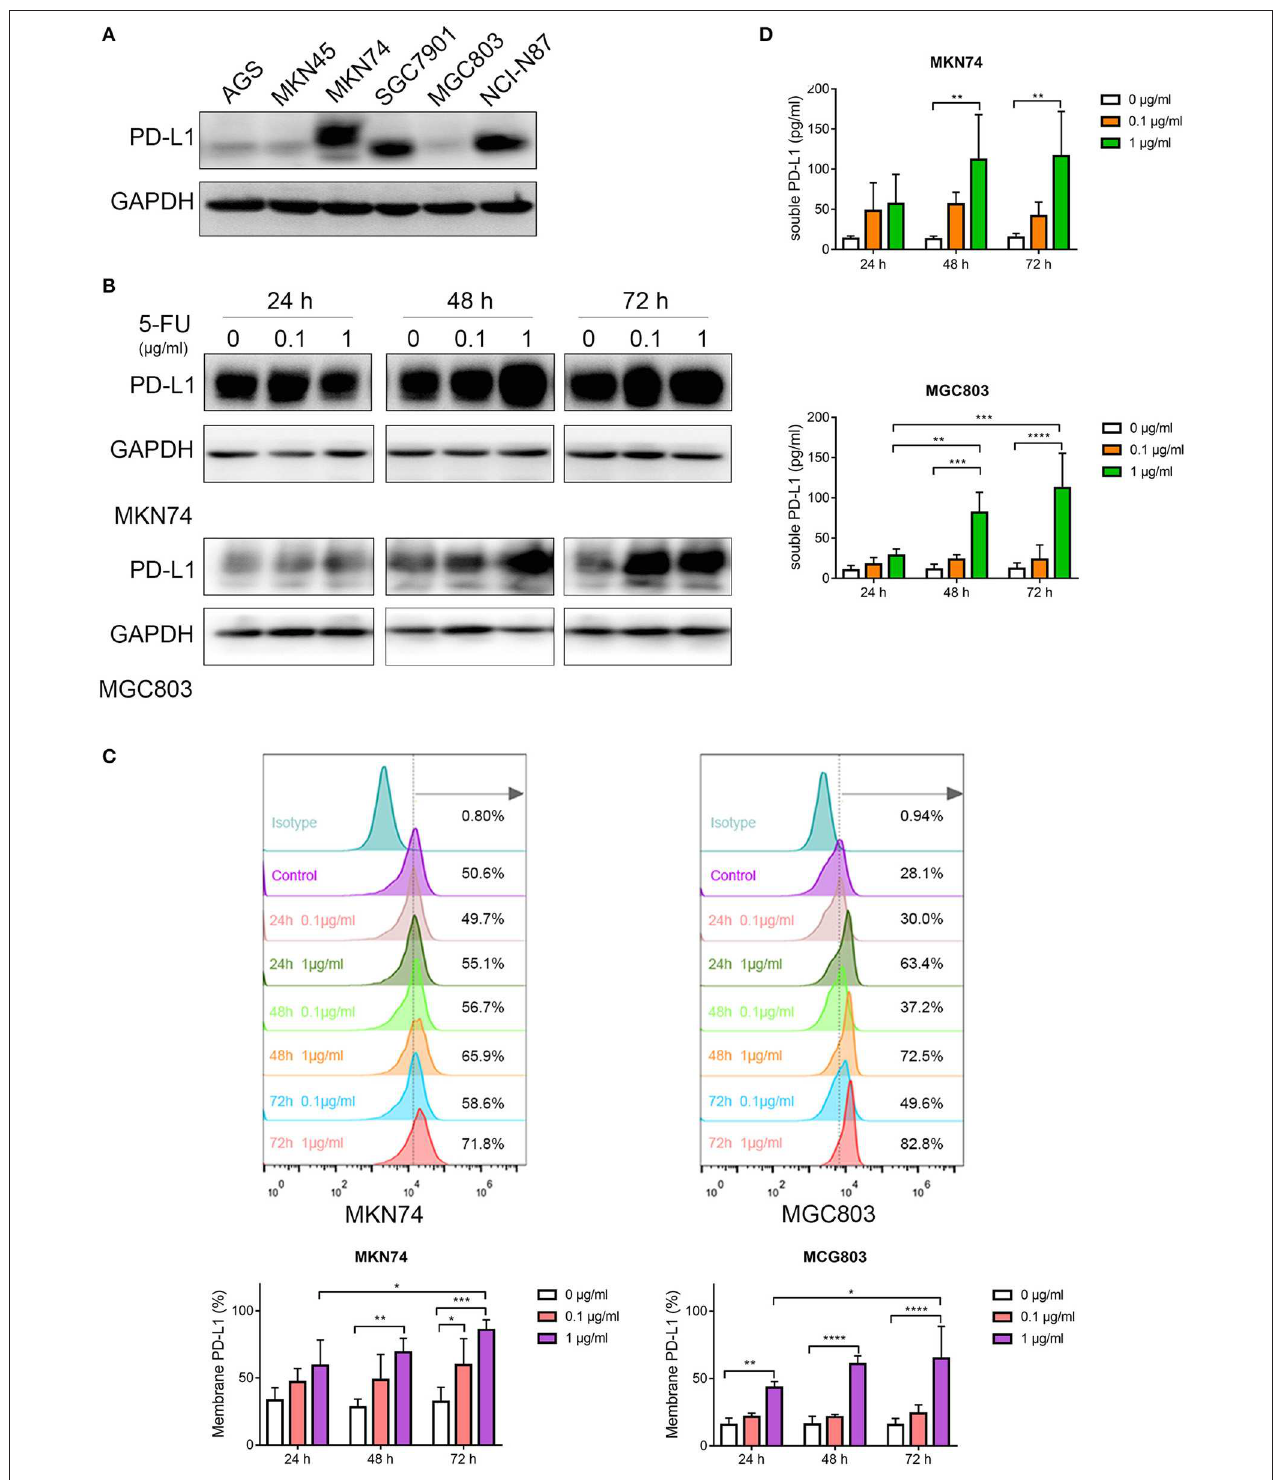
FIGURE 1 | 5-Fluorouracil (5-FU) upregulates programmed death-ligand 1 (PD-L1) in human gastric cancer cells. (A) Western blot was performed to measure PD-L1 levels in gastric cancer cell lines, including AGS, MKN45, MKN74, SGC7901, MGC803, and NCI-N87 cells. MKN74 and MGC803 cells were incubated with 5-FU (0, 0.1, 1.0 µ g/ml) for 24, 48, and 72h, respectively. (B) Western blot detected PD-L1 expression in MKN74 and MGC803 cells. (C) PD-L1 levels on the membrane of MKN74 and MGC803 cells were measured by flow cytometry. (D) Soluble PD-L1 levels in the cell culture supernatant were detected by ELISA. Data represent mean ± SD, P < 0.05 indicates that there existed statistical differences (* P < 0.05, ** P < 0.01, *** P < 0.001, **** P < 0.0001). Data were representative of three independent experiments.